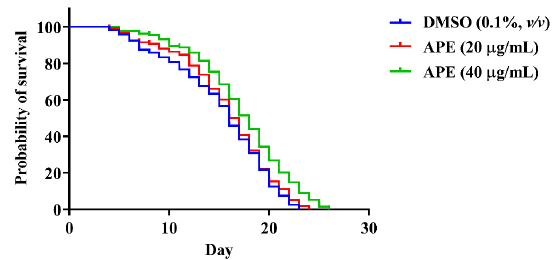
Figure 6. The effect of APE crude extracts on C. elegans lifespan. Table 2. Results and statistical analyses of the lifespan of C. elegans treated with APE.